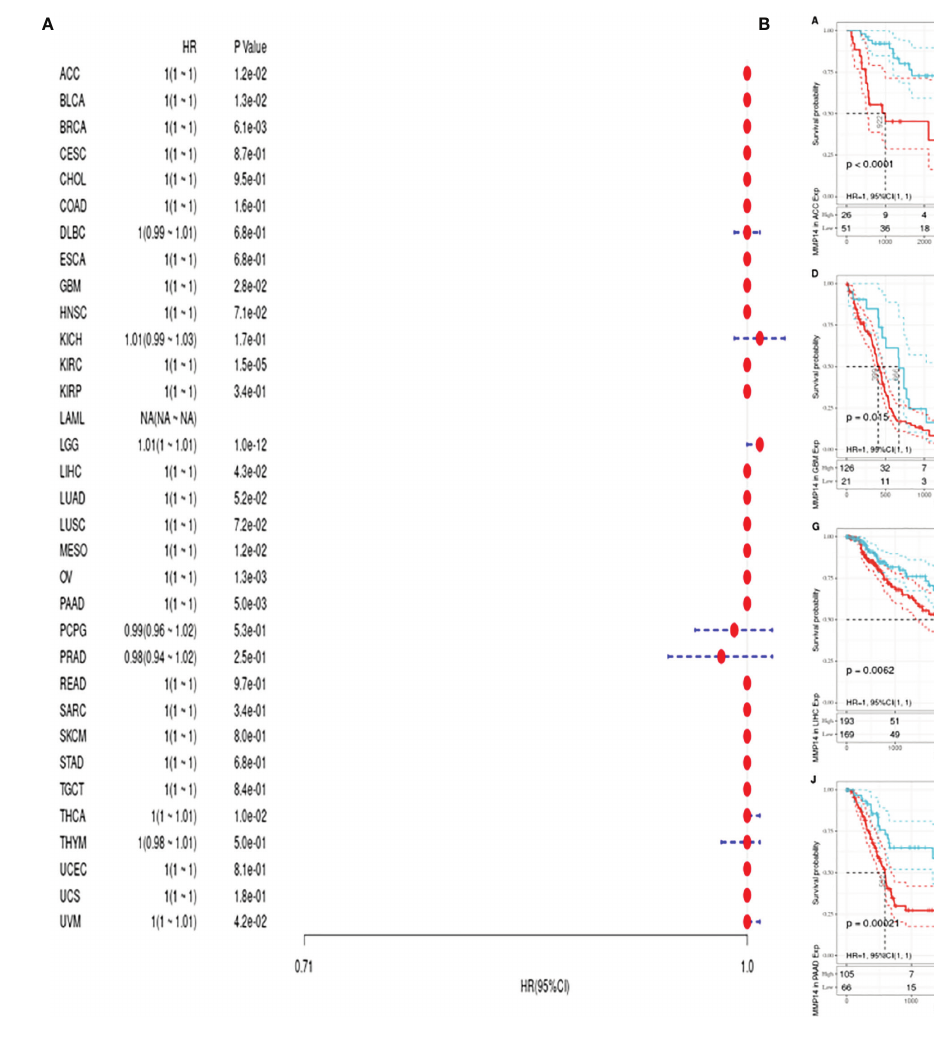
FIGURE 4 | The expression of matrix metalloproteinase 14 (MMP14) and the prognosis of disease-speci fi c survival (DSS) were analyzed. The relationship between MMP14 expression and disease-free survival was analyzed by DSS. The expression of MMP14 and the overall survival rate of pan-cancer were analyzed by DSS. (A) Correlation analysis of MMP14 expression and DSS in different cancer types of The Cancer Genome Atlas (TCGA). The red part represents the risk ratio. Due to the limited sample size, the parameters and hazard ratio could not be calculated with short bars, and the red font indicates p < 0.05. (B) Kaplan – Meier analysis was used to generate a survival curve for the prognostic effect of MMP14 expression on pan-cancer. DSS, disease-speci fi c